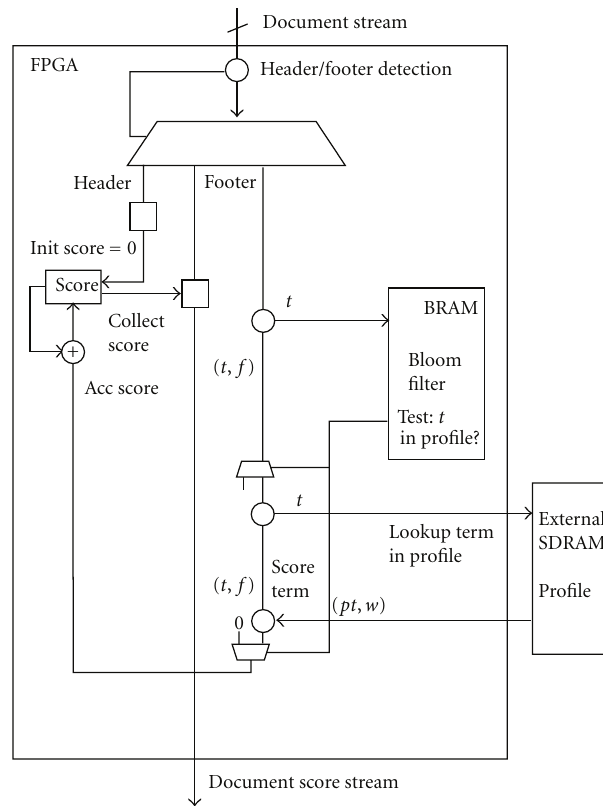
Figure 1: Sequential document term